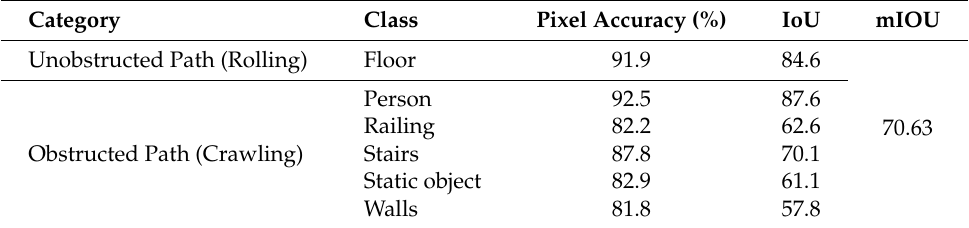
Table 4. Statistical measures for online locomotion mode recognition.